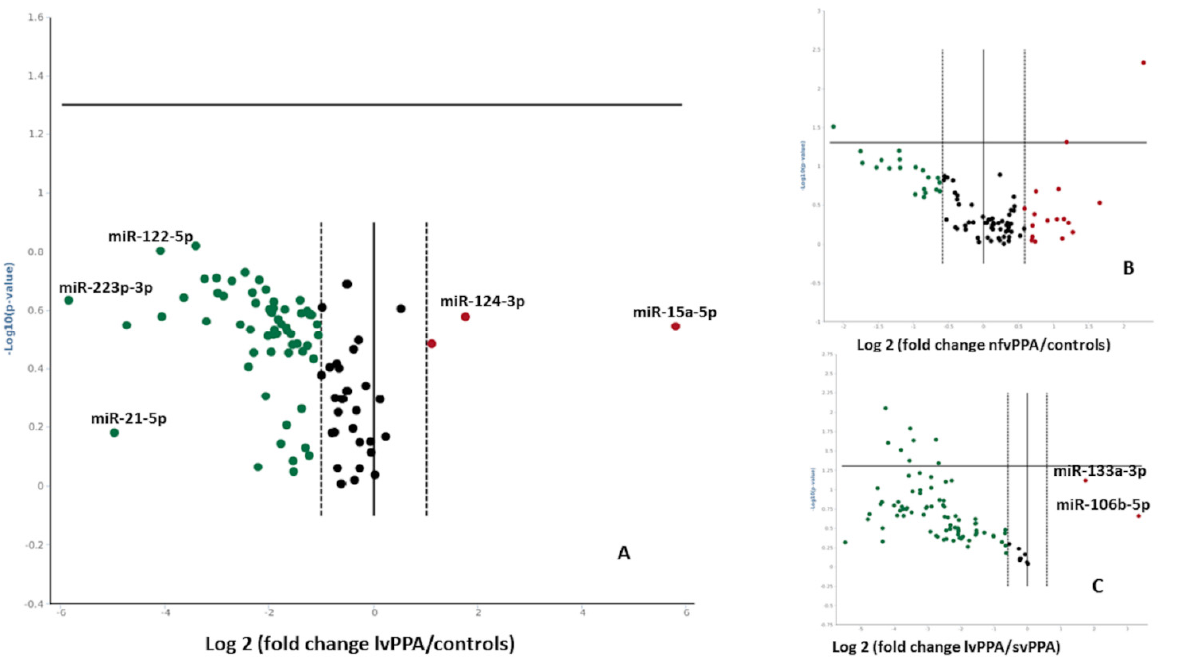
Figure 3. Volcano plots ( A ) lvPPA versus controls ( B ) nfvPPA versus controls ( C ) lvPPA versus svPPA. Data are expressed as Log 2 (fold change) and each dot represents one miRNA. Green indicates downregulation, red upregulation and black dots represent either miRNA that are below the fold change cutoff.